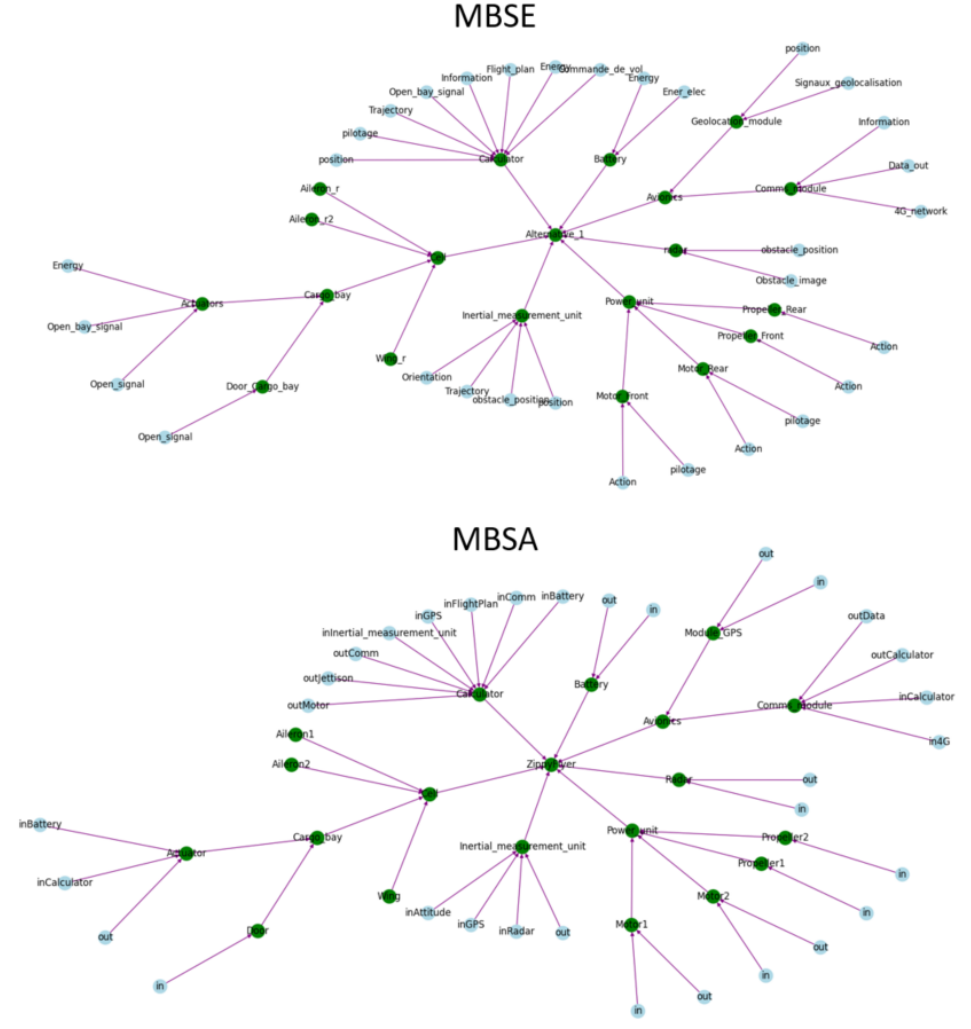
Figure 17. Diagrams for the A (cid:48) and B (cid:48) S2ML models of the fixed wing drone at the final compari- son